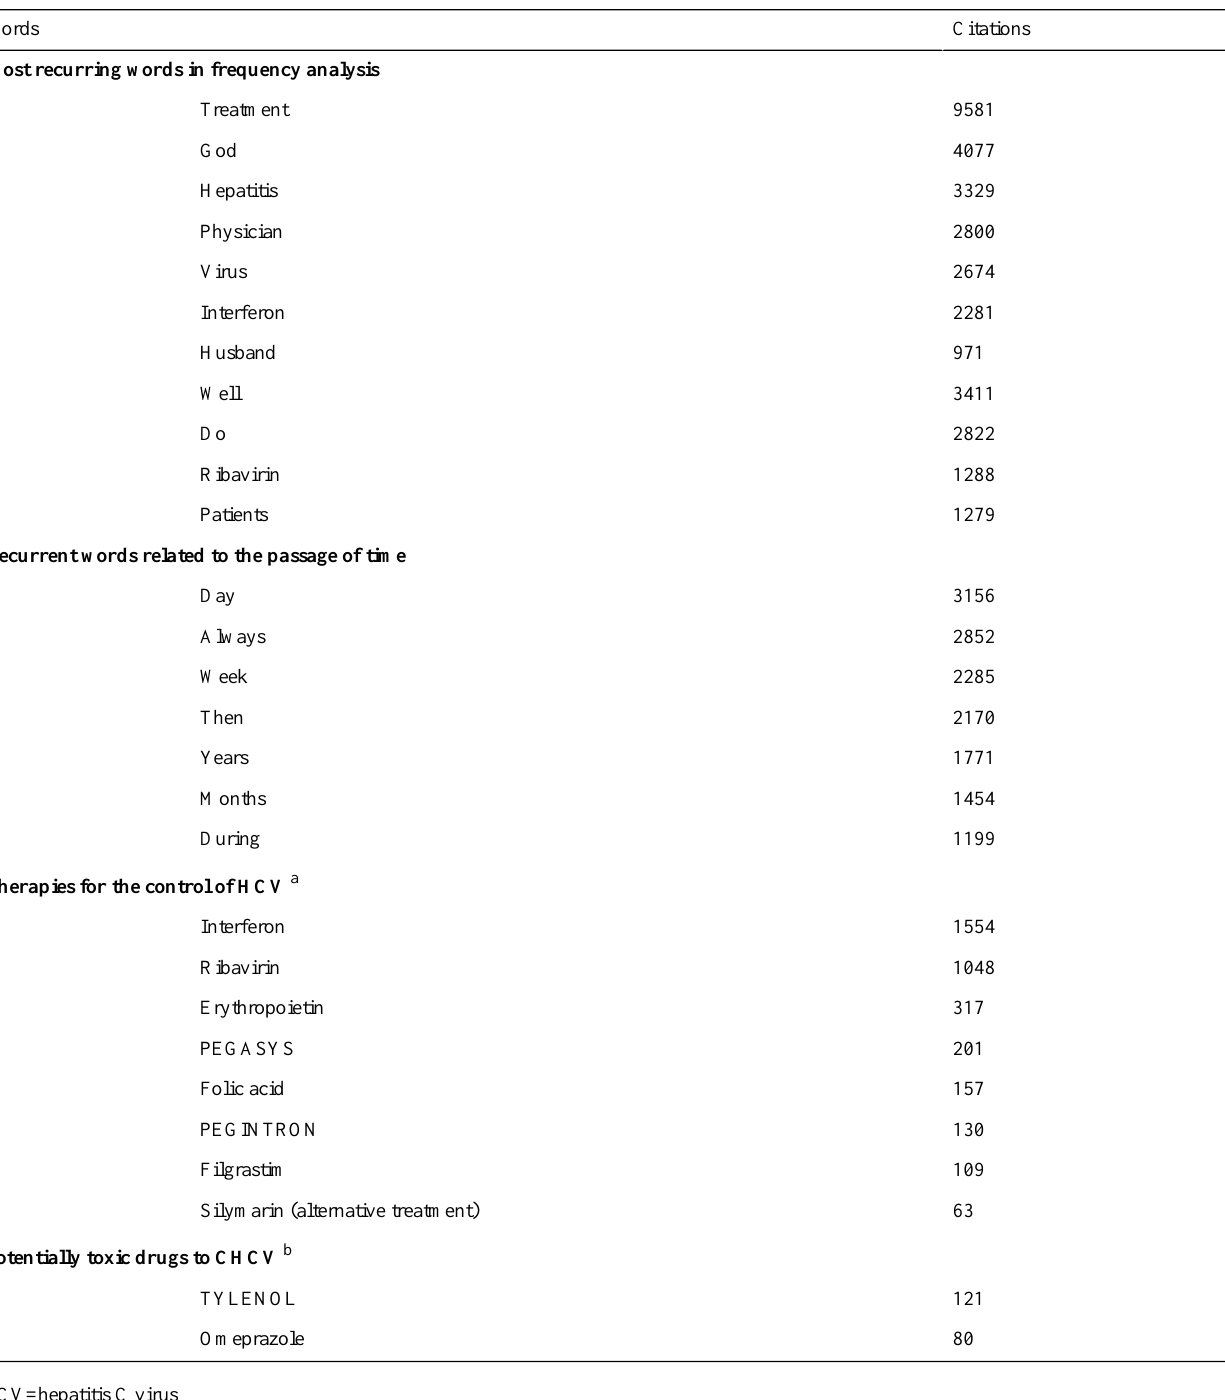
Table 1. Subset of prominent words from the Dominant Community forum (translated to English).